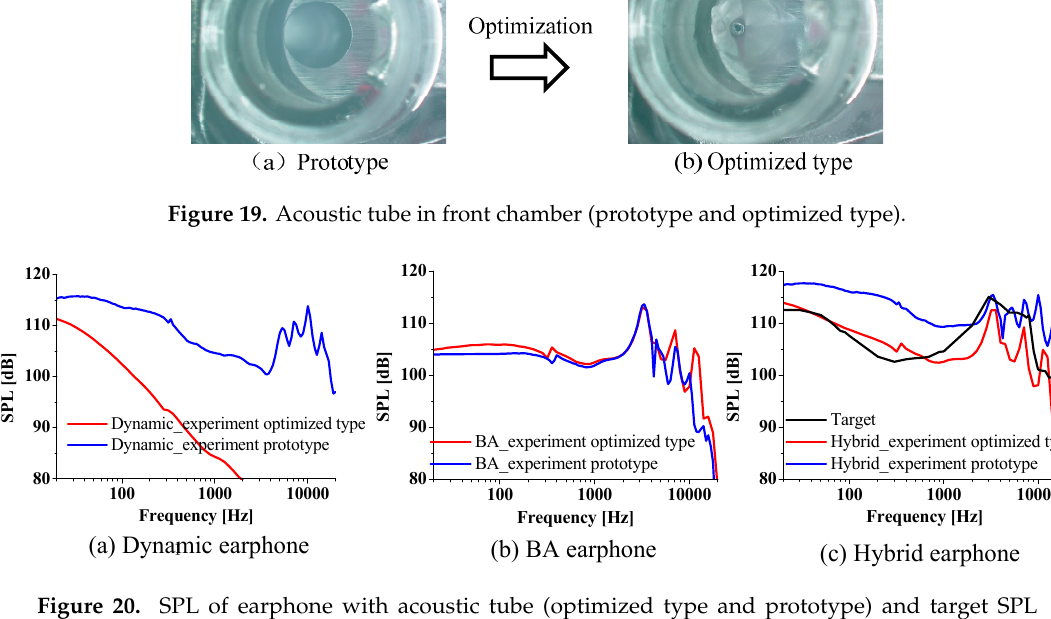
Figure 20. SPL of earphone with acoustic tube (optimized type and prototype) and target SPL (experiment result).